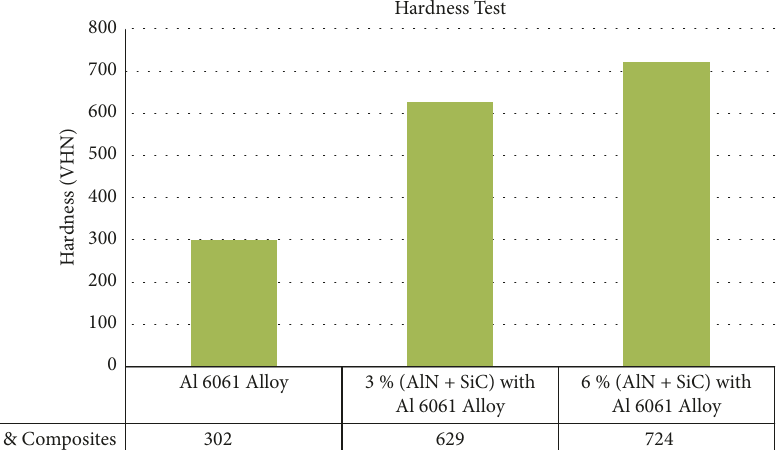
Figure 9: Hardness test results.